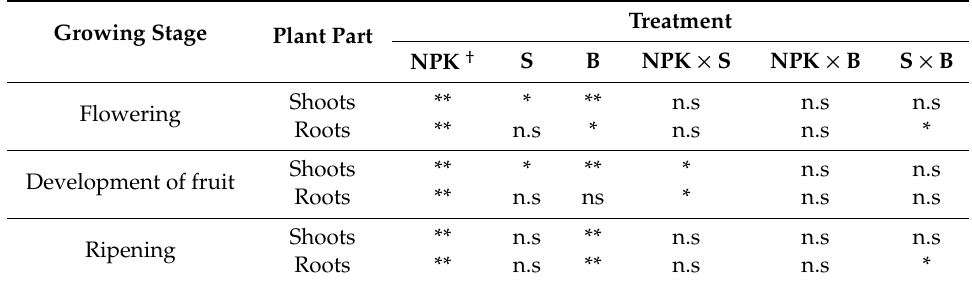
Table 3. Accumulation of P. Significance of experimental factors and their interaction, * P ≤ 0.05; ** P ≤ 0.01, mean 2011–2013.